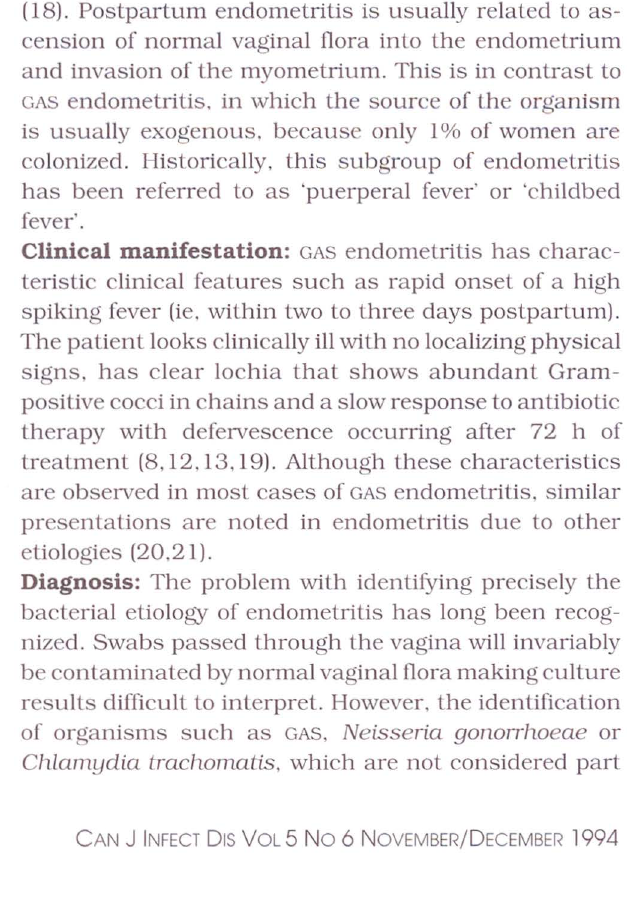
Figure 1) Restriction enzyme analysis patterns following diges tion of extracted DNA with Hind IT/. Lanes 1 and 2 are